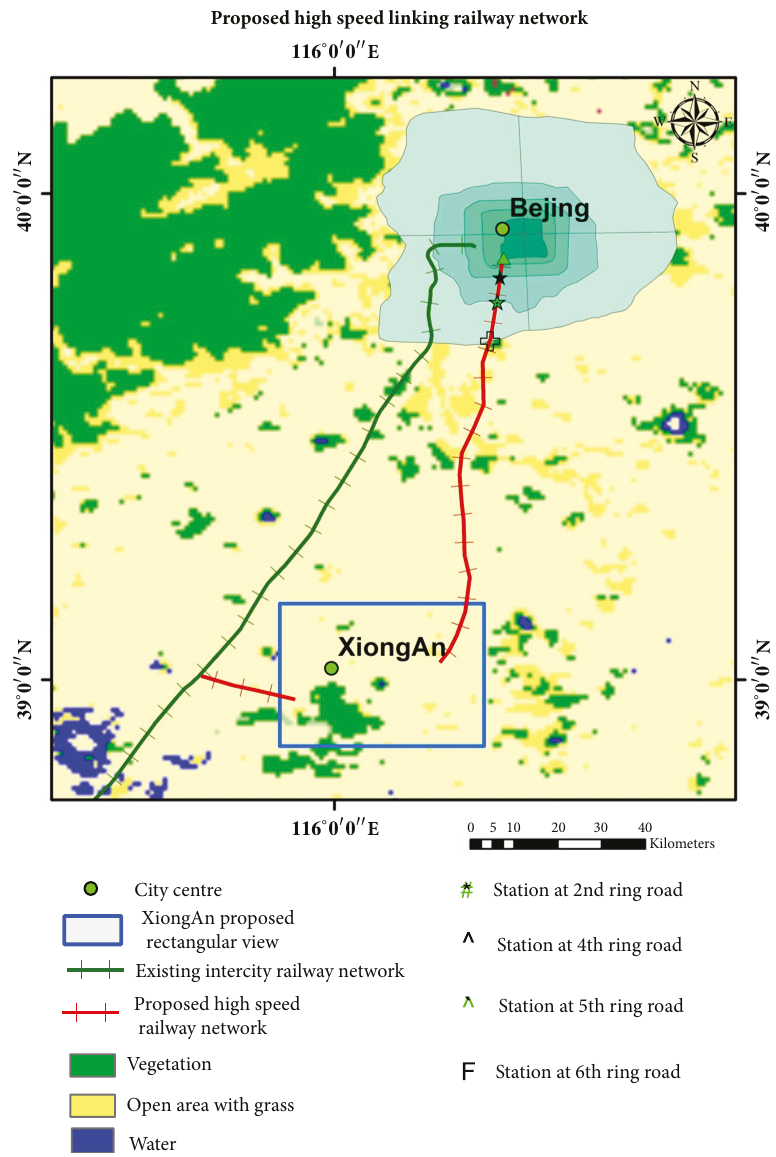
Figure 4: Inter-city railway network and proposed high-speed railway